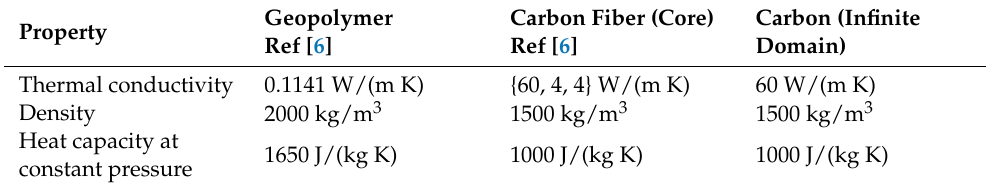
Table 1. Thermal conductivity properties of carbon fiber reinforced geopolymer composite.